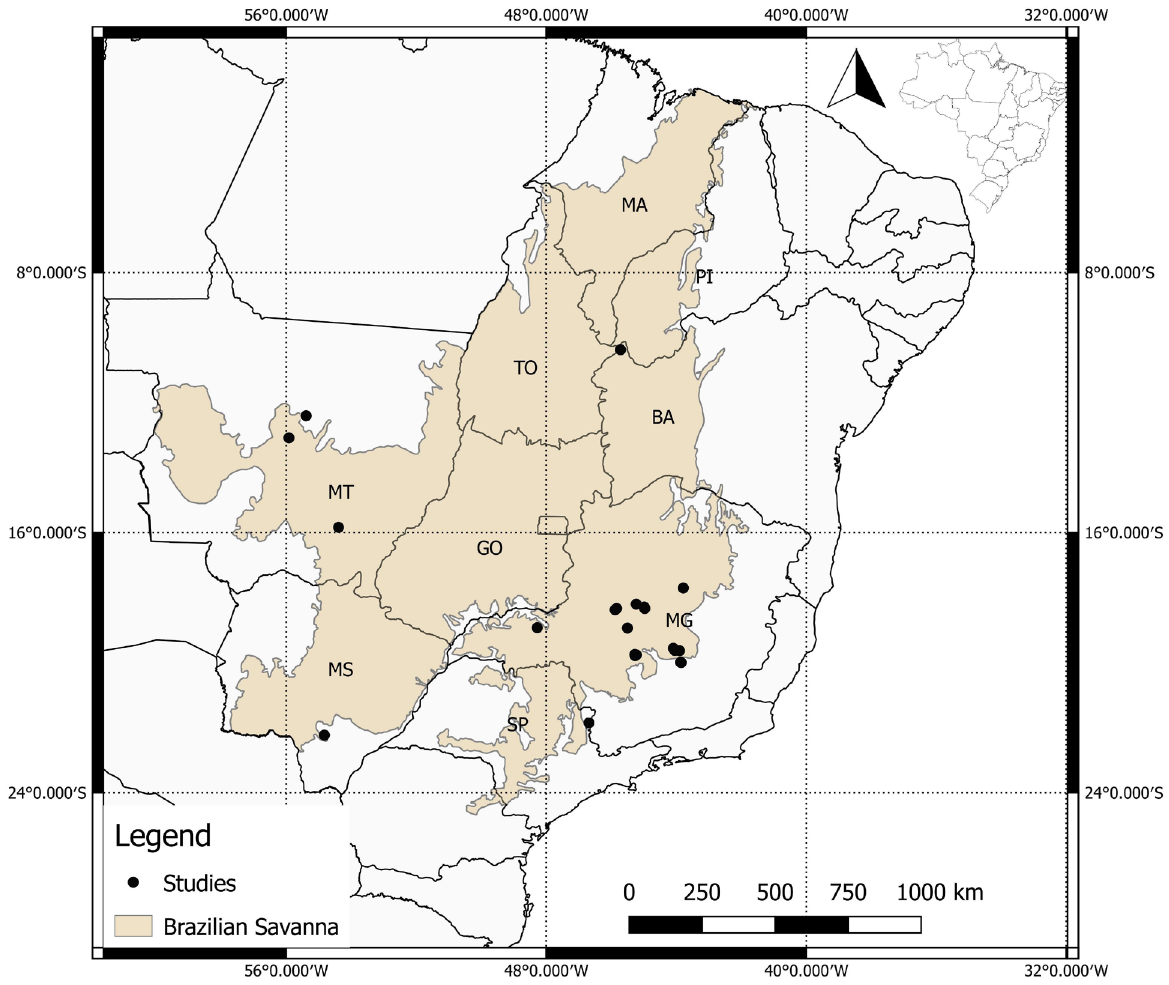
Fig 2 . States sampled and studies conducted between 1986 and 2016 in the Brazilian Savanna. Some studies are in transitional areas such as Mato Grosso do Sul (MS) and São Paulo